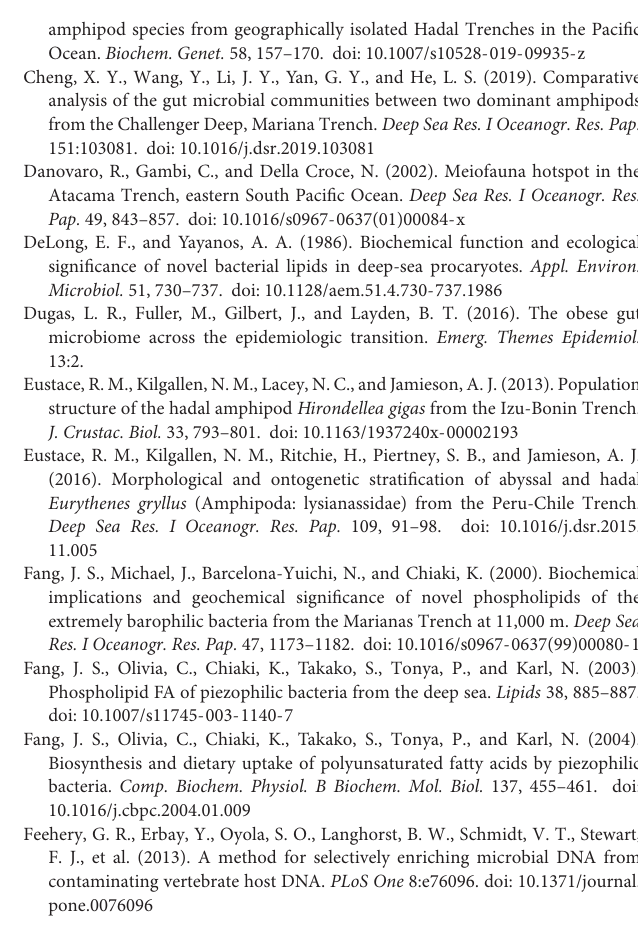
Supplementary Figure 1 | Gene Ontology (GO)classification of the total non-redundant protein-coding genes from all intestinal samples. Supplementary Figure 2 | Extended error bar plot considering differences of GO functional categories between the three hadal amphipod species. Different colors indicate different groups. The rightmost is the P value. Supplementary Figure 3 | Phylogenetic and domain composition analysis of MCPs from different microbial species. The phylogenetic tree was analyzed by maximum likelihood with Tamura-Nei model. The bootstrap values were indicated on the branches of the tree. Protein domain prediction was performed by SMART tool. Different domain types are represented by different graphic shapes. Supplementary Figure 4 | Network plots showing correlations between probiotic effects and categories of predicted gene functions in hadal amphipods. Significant correlations between probiotic effects and functional gene categories are connected by nodes and straight lines. The size of the nodes and thickness of the lines represents the correlation strength. The larger the nodes and thicker the lines indicated the higher the correlations. The more lines indicate the closer correlations. Supplementary Table 1 | Summary of sequencing data for each sample. Supplementary Table 2 | Assembly result statistics of metagenomic